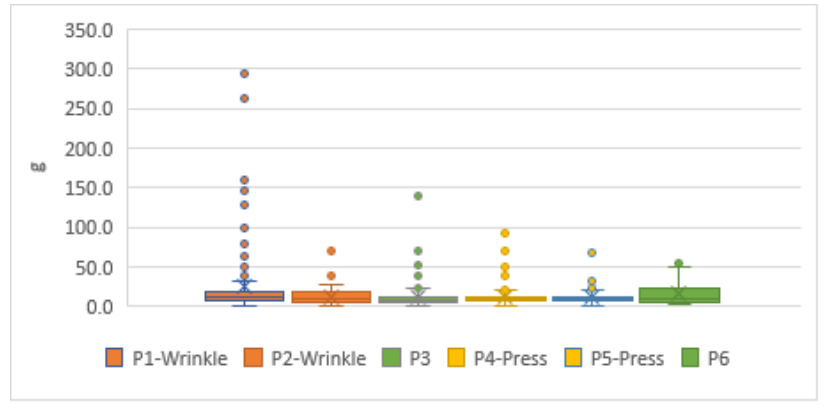
Figure 5. The pressure boxplot of a simulation test for short arm-cast splint on a simulated arm.